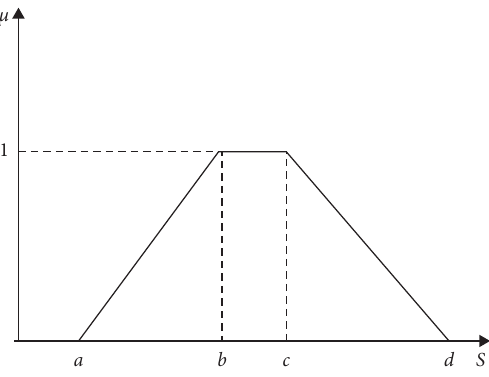
Figure 1: Triangular fuzzy number.